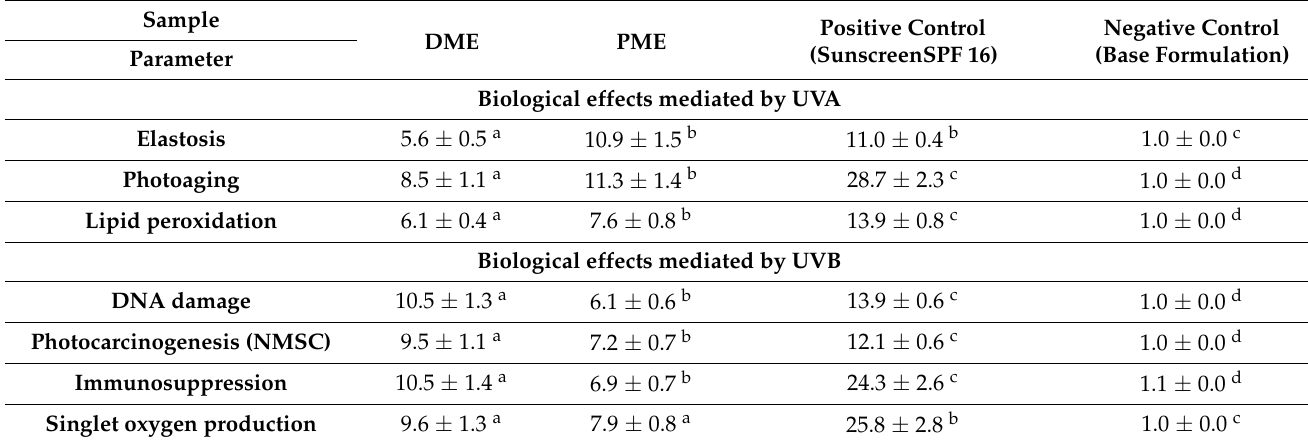
Table 3. Values of Biological Effective Protection Factors (BEPFs) for formulations containing